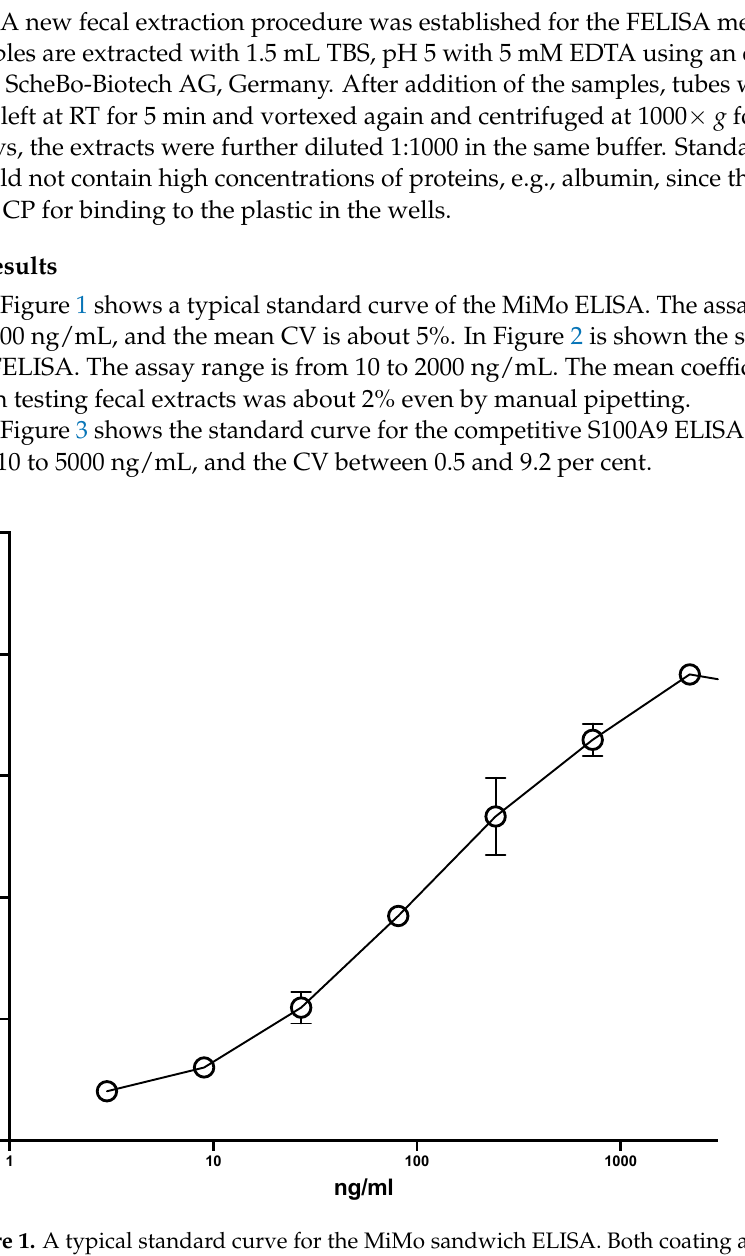
Figure 1. A typical standard curve for the MiMo sandwich ELISA. Both coating and HRP conjugate were MiMo. Incubation periods: 40 min with samples; 30 min with conjugate and 30 min with substrate. Normally, the assay range is 5 to 1000 ng/mL; CV values for duplicate standards were between 0.1 and 11.9. They are mainly affected by pipetting imprecision. Standard: recombinant calprotectin in TBS with 2 mM calcium chloride. CV for standards were between 0.1 and